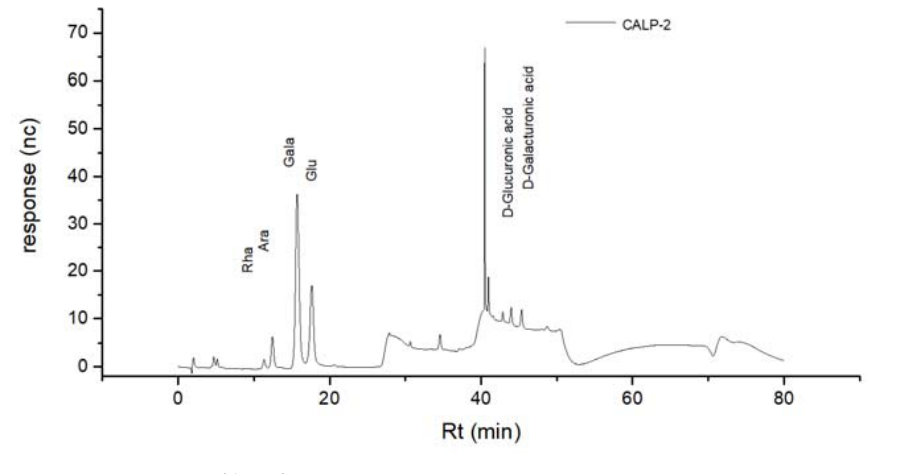
Figure 8. HPAEC profiles of CALP-2. Table 2. Monosaccharide composition and molar ratio of CALP ‐ 1 and CALP ‐ 2.